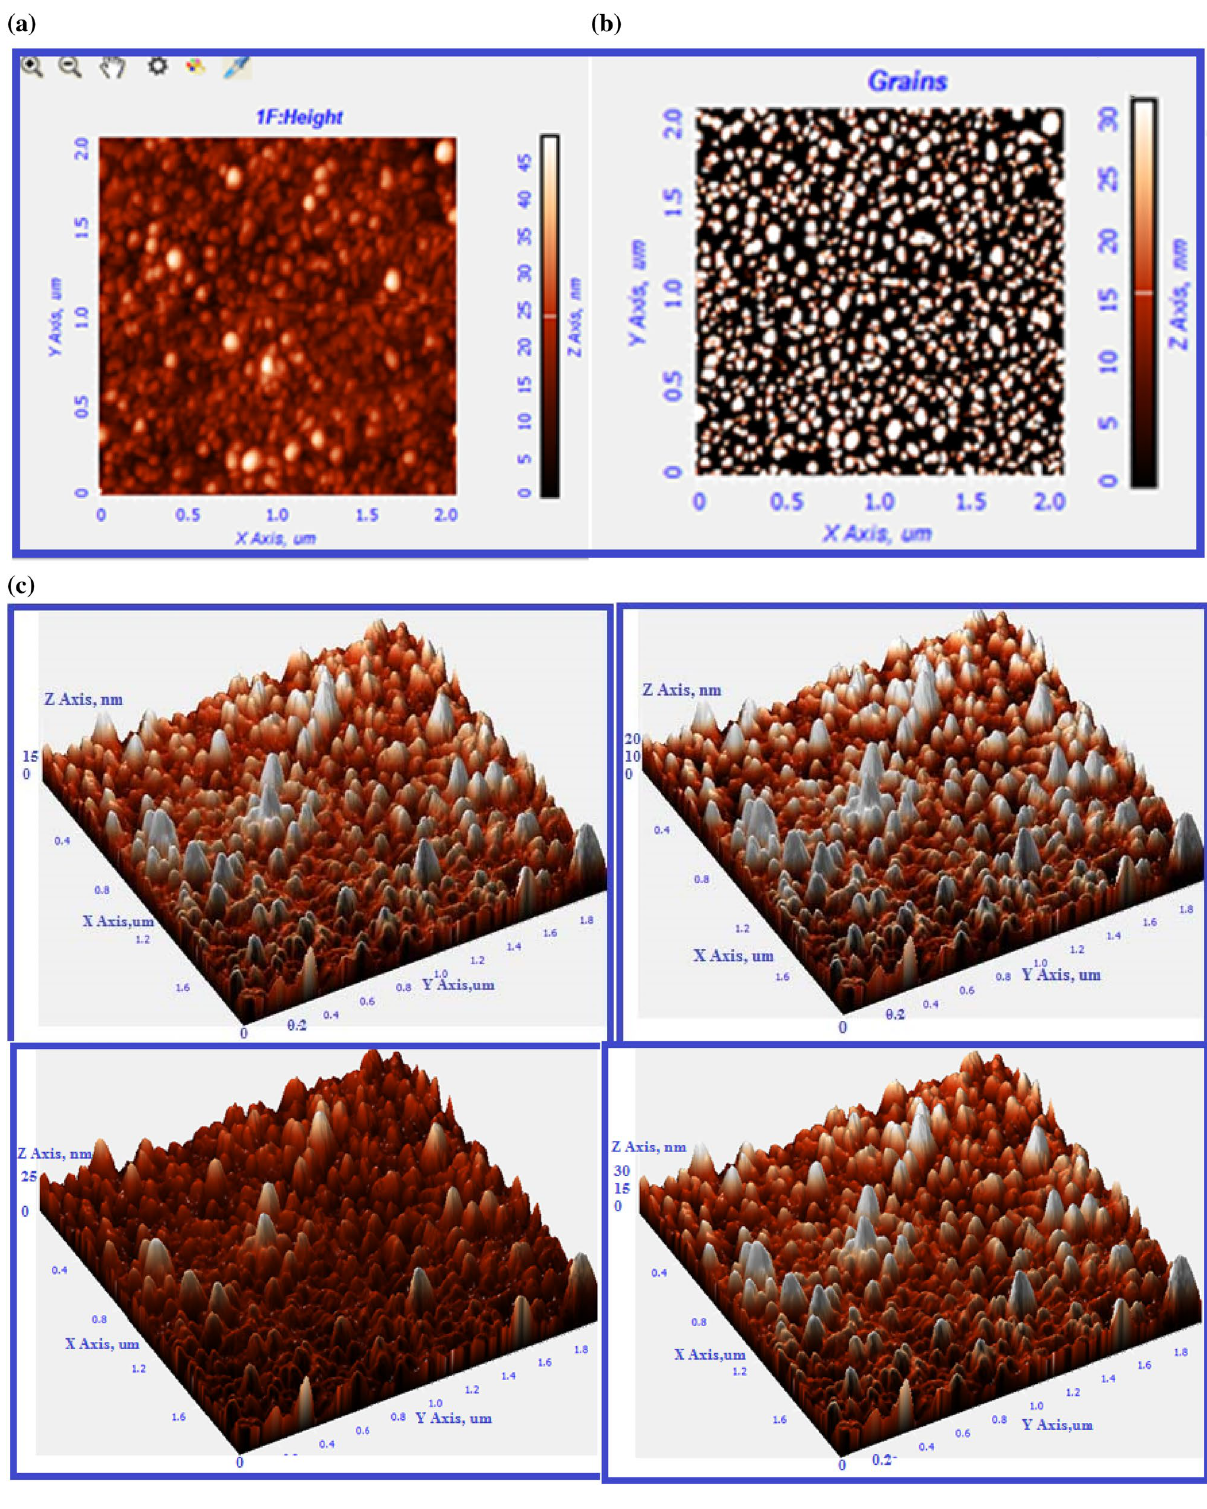
Figure 6. ( a ) 2D image of biosynthesized Ds-AgNPs. ( b ) Grains detected. ( c ) 3D image of biosynthesized Ds-AgNPs. Grains analysis of Ds-AgNPs by Z coloration